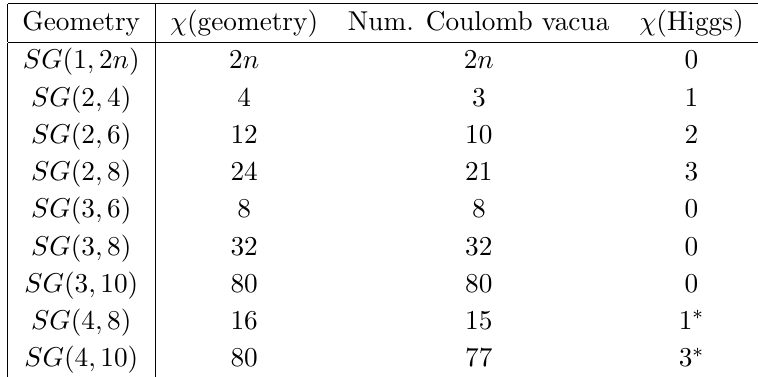
Table 1 . Listed are Euler characteristics of large radius phases, number of Coulomb vacua, and Witten indices of Higgs branches of r (cid:28) 0 phases. In each case, the sum of the number of Coulomb vacua and Higgs Witten indices matches the large-radius Euler characteristic, as expected. Euler characteristics of geometries are computed using the exact expression in section 2.1, and Coulomb vacua were counted either analytically or, in some cases, numerically. Euler characteristics of Higgs branches are as given in section 2.1. For the latter, we only have an exact result for cases k odd and k = 2. For the case k = 4, we made a conjecture in section 2.1, whose result we list here. We denote conjectured results with an asterisk ( (cid:3) ), and observe that they happen to have the correct values to preserve Witten